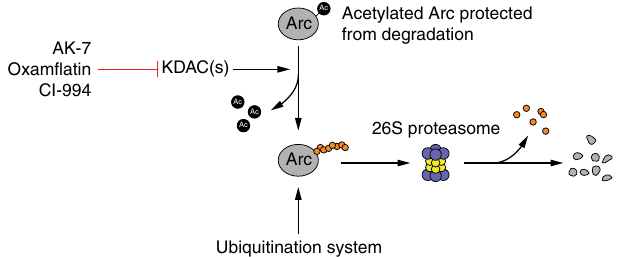
Fig. 10 Model of dynamic interplay between lysine acetylation and ubiquitination in the control of Arc protein stability and proteasomal degradation. Hypothetical model of how lysine acetylation could in fl uence the polyubiquitination of Arc protein and what in fl uence some of the KDAC inhibitors identi fi ed in our chemogenomic screen could exert on